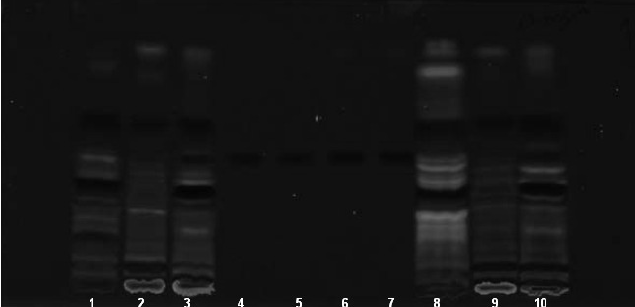
Figure 3. Chromatographic plate of standard chrysin with Oroxylum indicum vent at 366 nm BD * Ethanolic extract of Oroxylum indicum vent (1=WG leaf; 2= WG stem; 3= WG root; 4,5= Ch 2 µL ;6,7=Ch 5 µL; 8= UP leaf; 9= UP stem; 10= UP root)WG: Western Ghats; UP: Uttar Pradesh; Ch: Standard